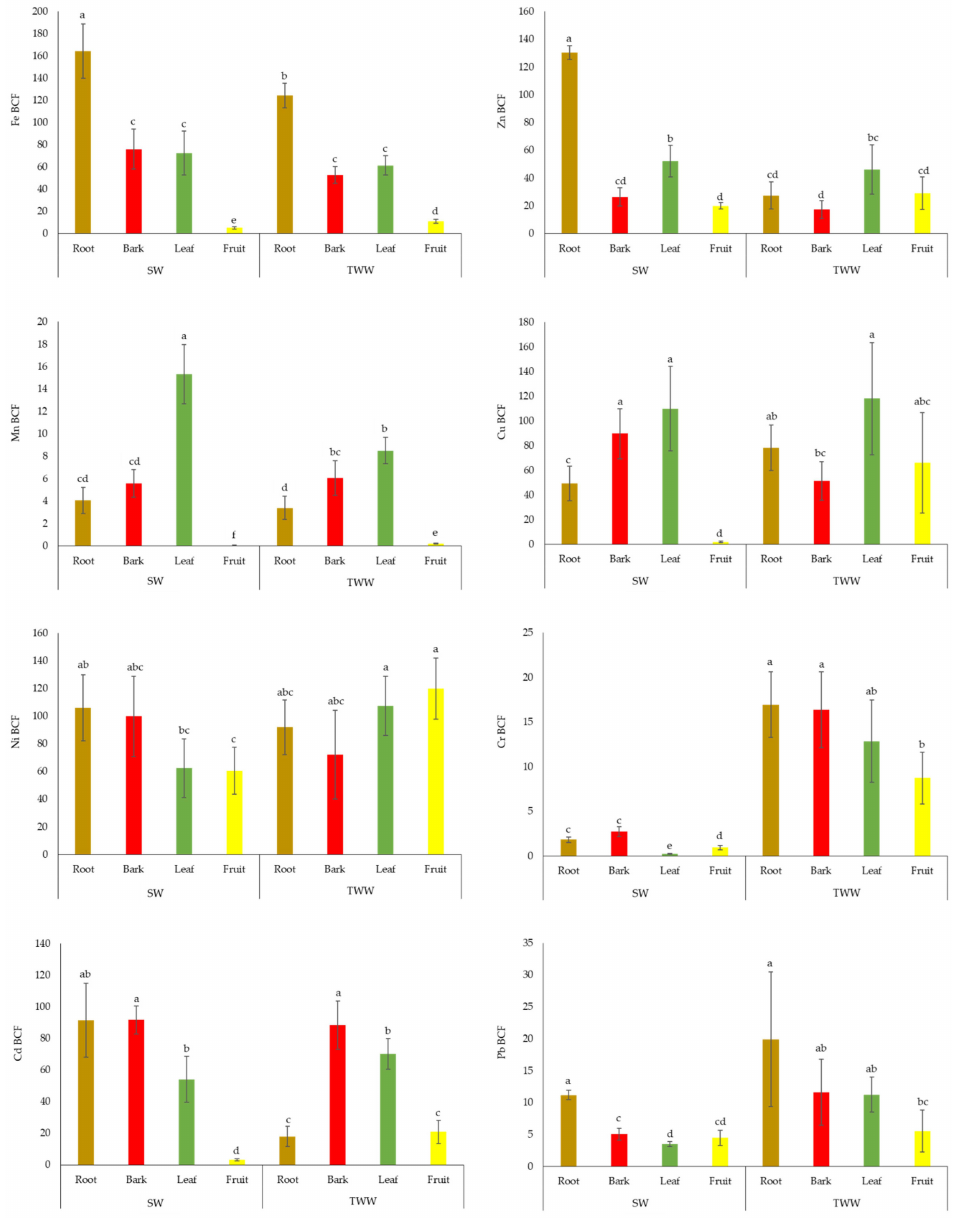
Figure 1. Bioconcentration factors (BCF) of different heavy metals in different parts of lemon trees irrigated with spring water (SW) and treated wastewater (TWW) at the Wadi-Musa region. Bars represent mean ± SD ( n = 4). Different letters indicate significant differences according to LSD ( p <